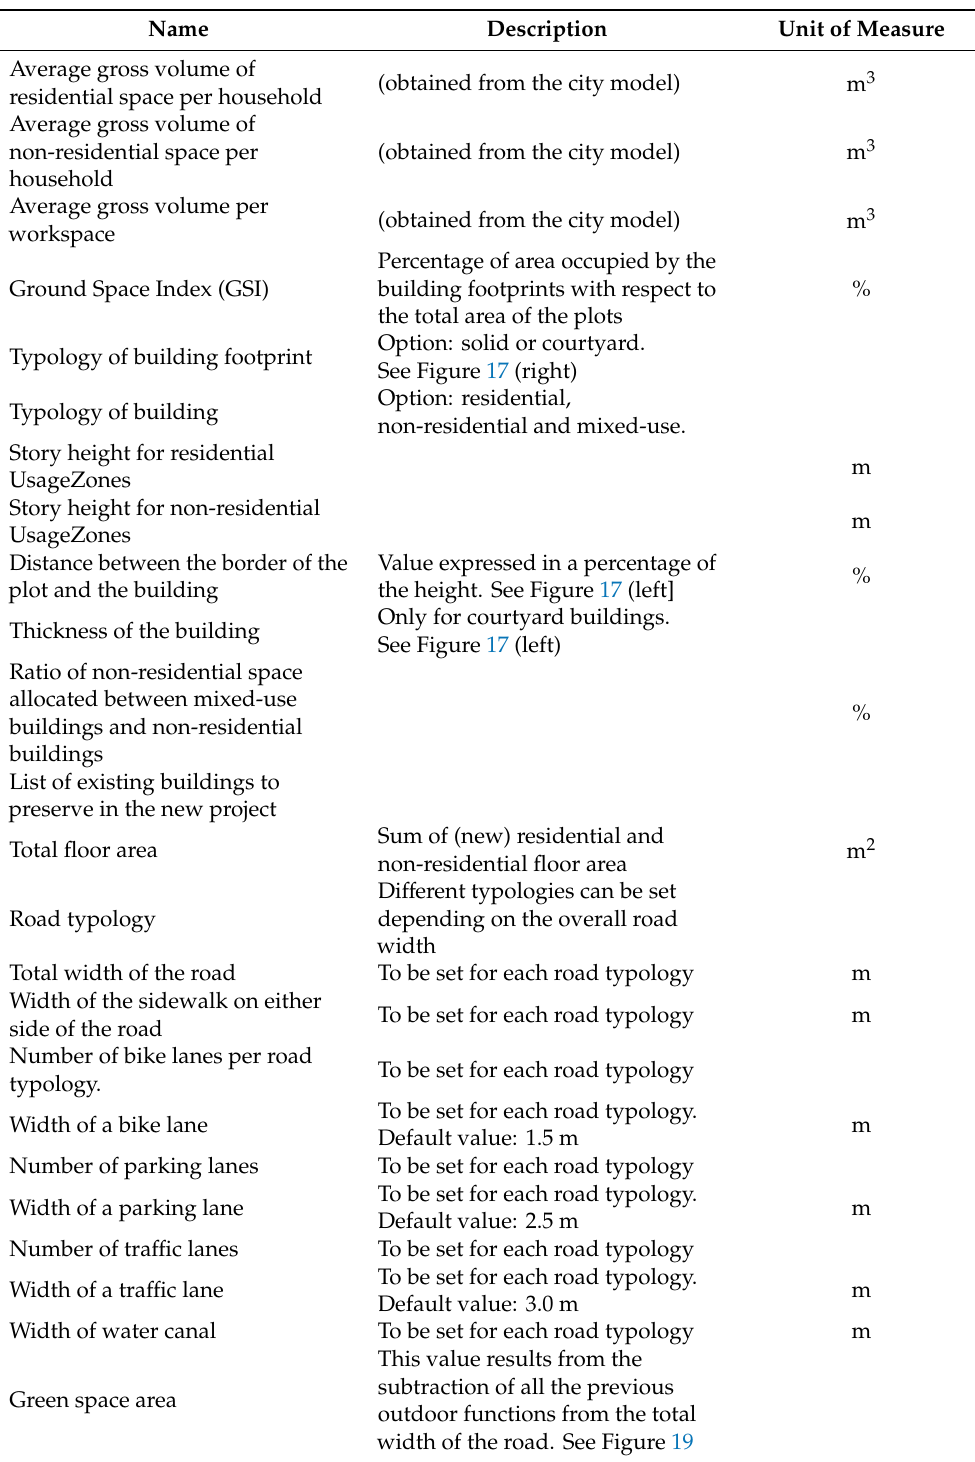
Table 5. Excerpt of list of internal design